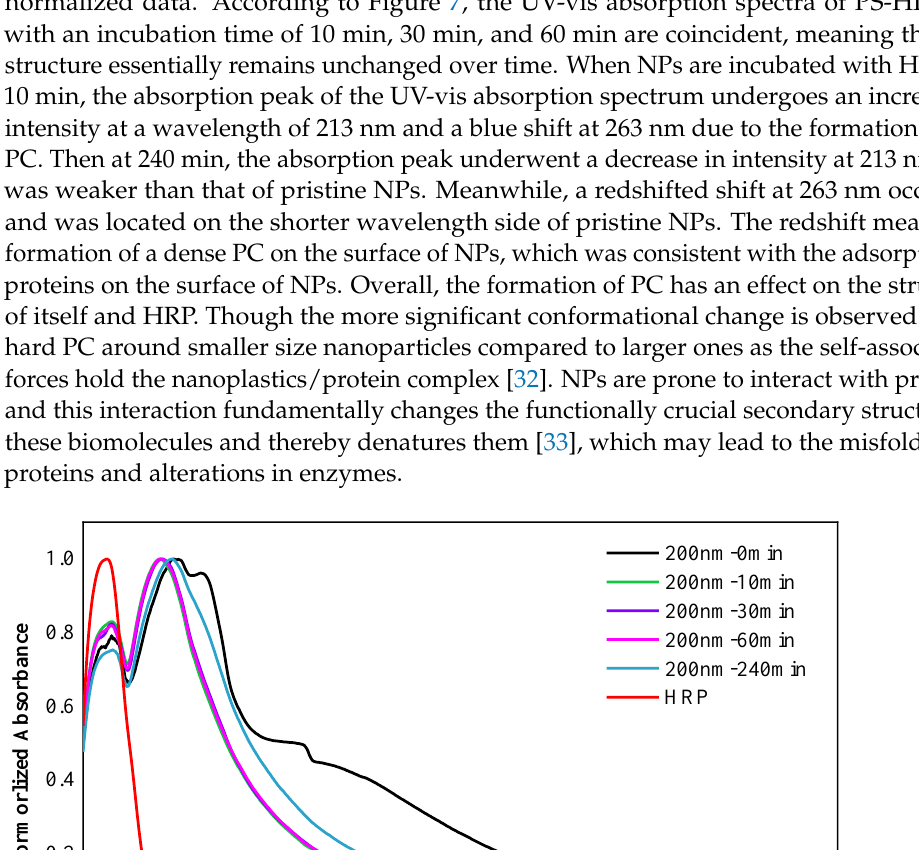
Figure 6. Relative activity changes of HRP with incubation time. Dates are means ± SE ( n = 3). Dif- ferent letters indicate a significant difference at p < 0.05.